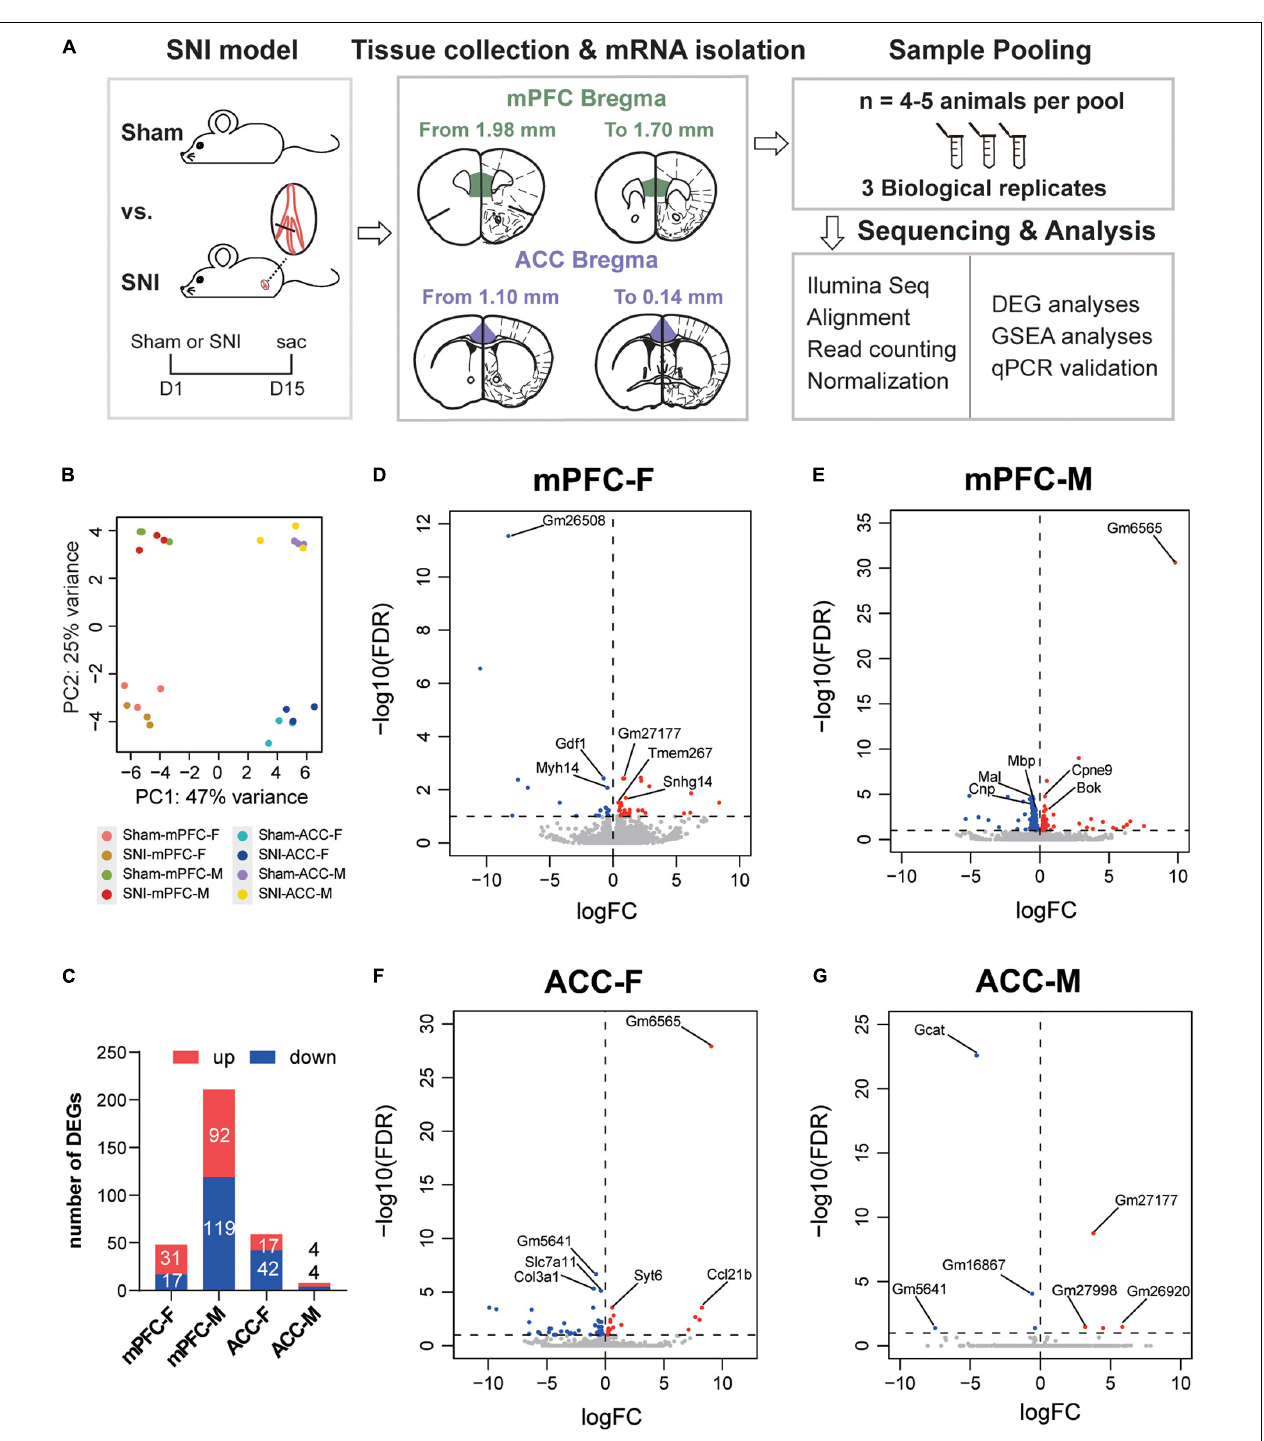
FIGURE 2 | Differentially expressed genes in the mPFC and the ACC of female and male mice at 2 weeks after SNI surgery, compared to the sham group. (A) Experimental design and the workflow of the RNAseq and analyses. (B) Principal component analysis (PCA) plot of the sham versus the SNI groups, depicting the clustering of samples: the mPFC versus the ACC, female versus male, and the sham group versus the SNI group. (C) The numbers of the significantly upregulated or downregulated differentially expressed genes (DEGs) by SNI. mPFC-F, the mPFC of female mice; mPFC-M, the mPFC of male mice; ACC-F, the ACC of female mice; ACC-M, the ACC of male mice. The volcano plots of the DEGs in the mPFC of female (mPFC-F, D ) and male mice (mPFC-M, E ), as well as in the ACC of female (ACC-F, F ) and male mice (ACC-M, G ), with horizontal lines at the –log 10 (false discovery rate, FDR) = 1 and vertical lines at log 2 (fold change, FC) = 0, delineating positive versus negative regulation. Blue dots represent downregulated DEGs, and red dots represent upregulated DEGs.